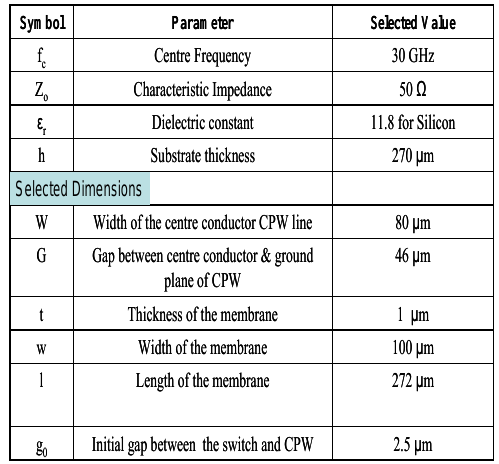
Table-II: Typical design dimensions for phase shifter